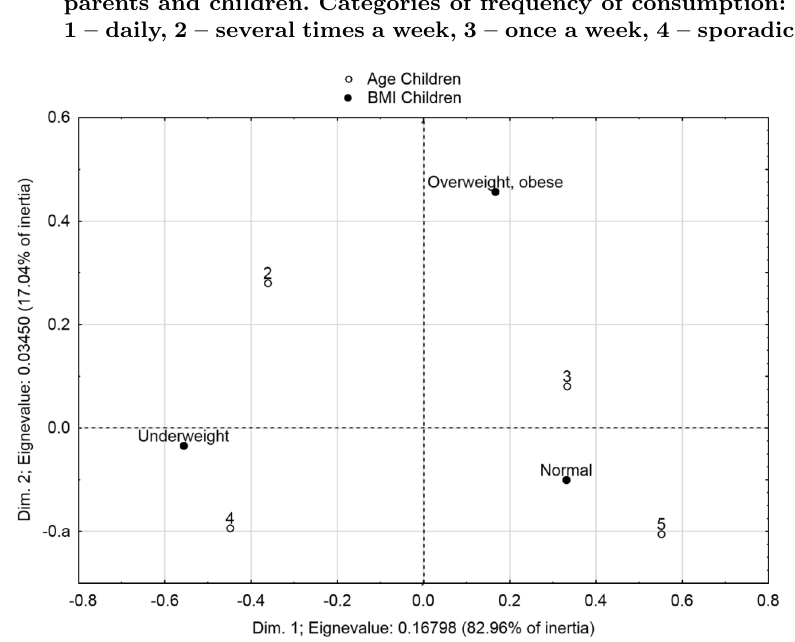
Figure 2. Correspondence map of the age of the first consumption of a fast-food product and the “child BMI” category. Age